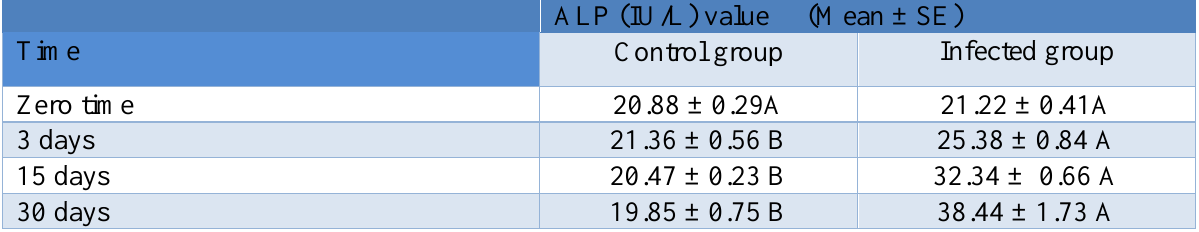
Table, 4: Effect of E. coli infection on ALP (IU/L) value of infected group compared with control group at zero time, 3,15 and 30 days post infection.